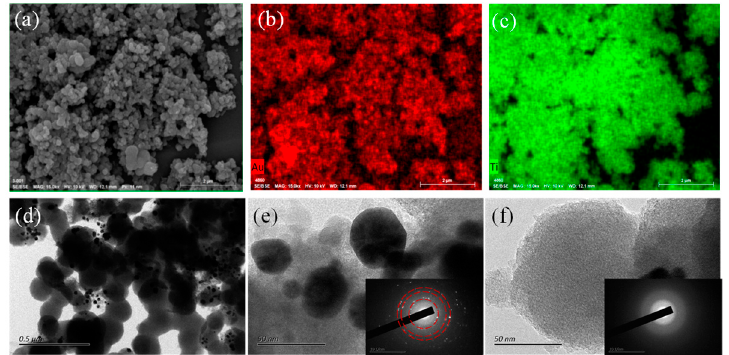
Figure 2. ( a ) SEM image of the sample after 30 min of Au 3+ and TiO 2 hydrate suspension irradiated by femtosecond laser; ( b ) EDS distribution of Au in AuNPs@a-TiO 2 nanoparticles; ( c ) EDS distribution map of Ti in AuNPs@a-TiO 2 nanoparticles; ( d ) Transmission electron microscope (TEM) image of AuNPs@a-TiO 2 ; ( e , f ) The local high-resolution transmission electron microscopy (HRTEM) images in ( d ), and the insets are electron diffraction images.